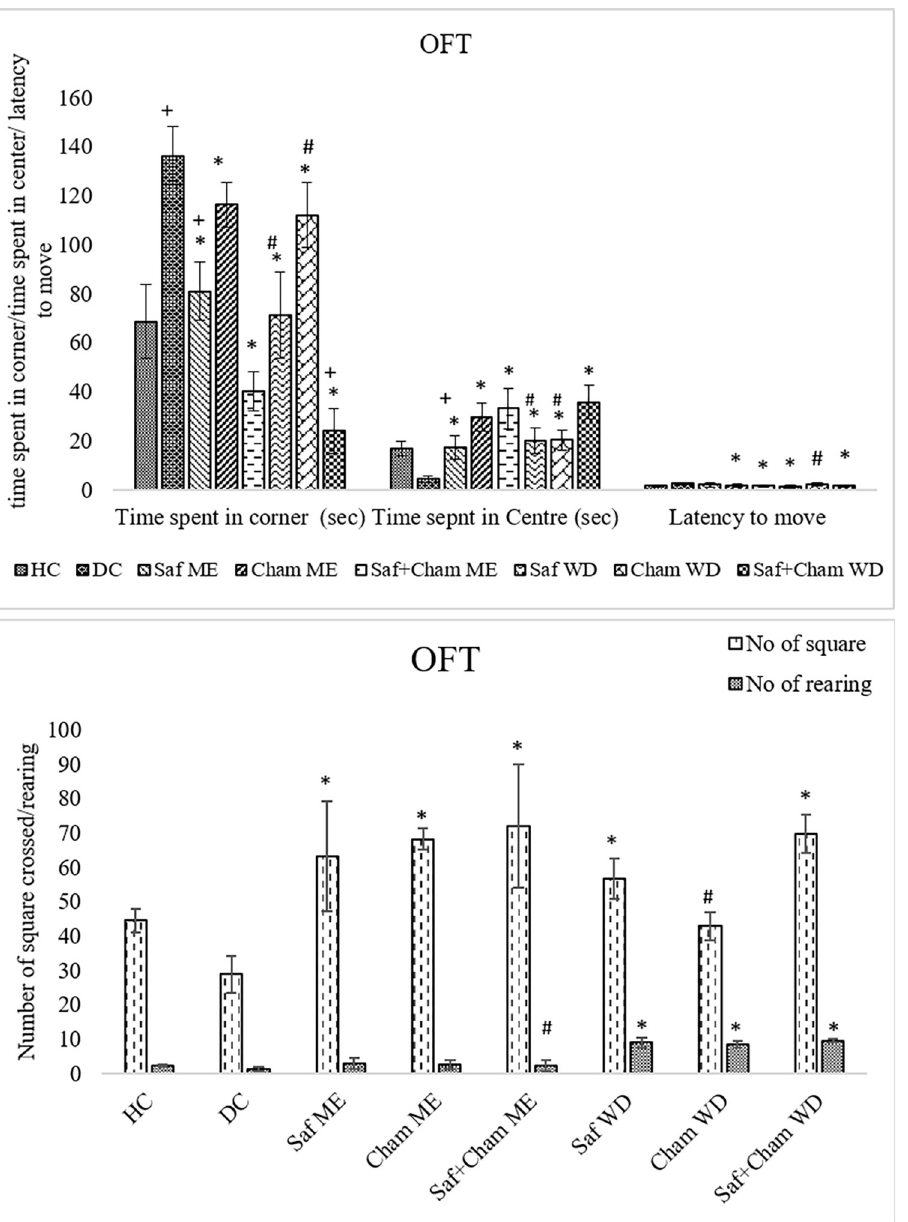
Fig 9. a: Effects of saffron, chamomile and their co-administration in ME and WD on OFT (time (sec)) in streptozotocin-induced diabetic rats. Values are presented as means ± SD (n = 10). Tukey’s test significant values: � p < 0.05 from control DC, + p < 0.05 from Saf+Cham ME group, # p < 0.05 from Saf+Cham WD. b: Effects of saffron, chamomile and their co-administration in ME and WD on OFT (number of squares crossed / rearing) in streptozotocin-induced diabetic rats. Values are presented as means ± SD (n = 10). Tukey’s test significant values: � p < 0.05 from control DC, + p < 0.05 from Saf+Cham ME group, # p < 0.05 from Saf+Cham WD.